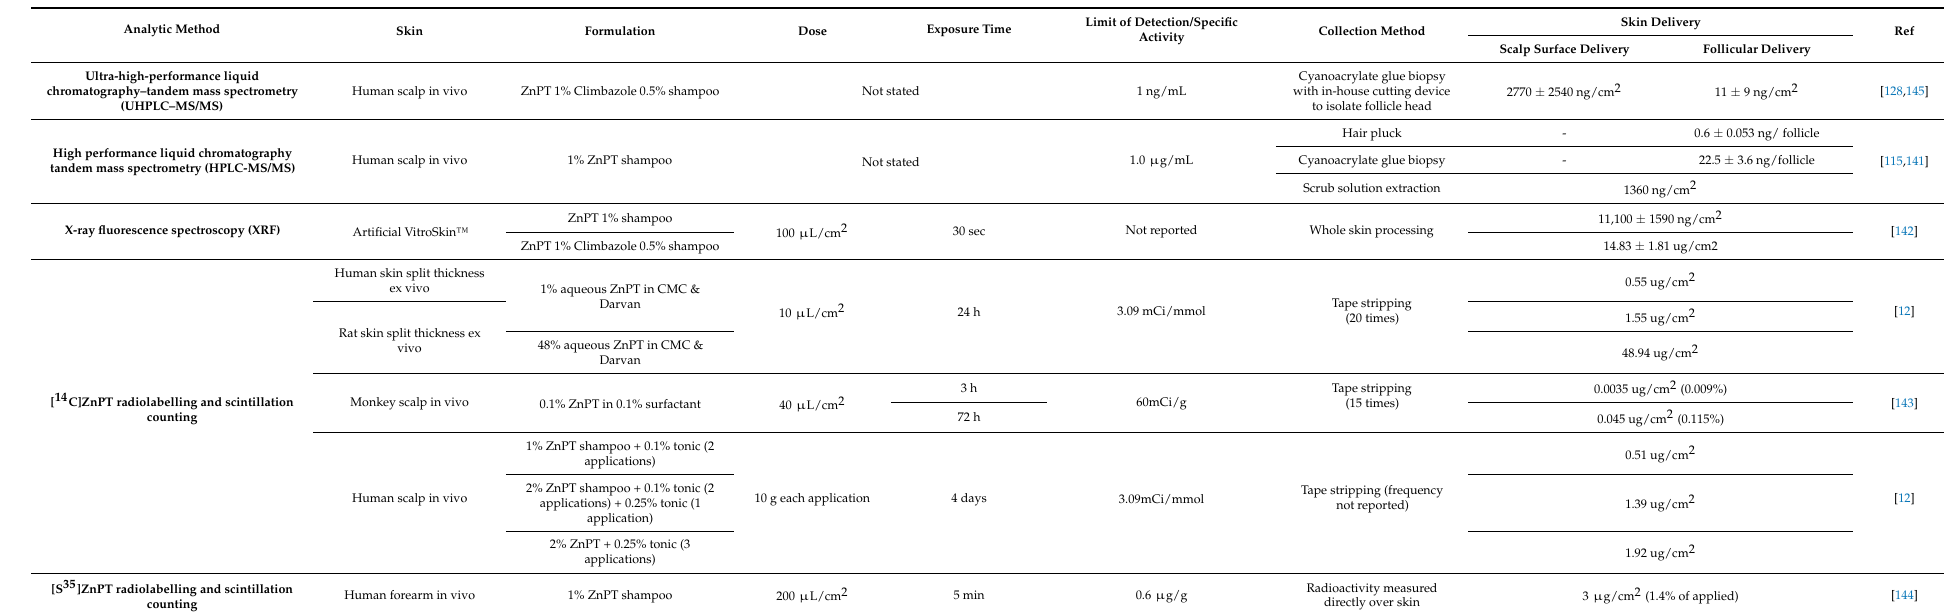
Table 2. Quantification of zinc pyrithione delivery to